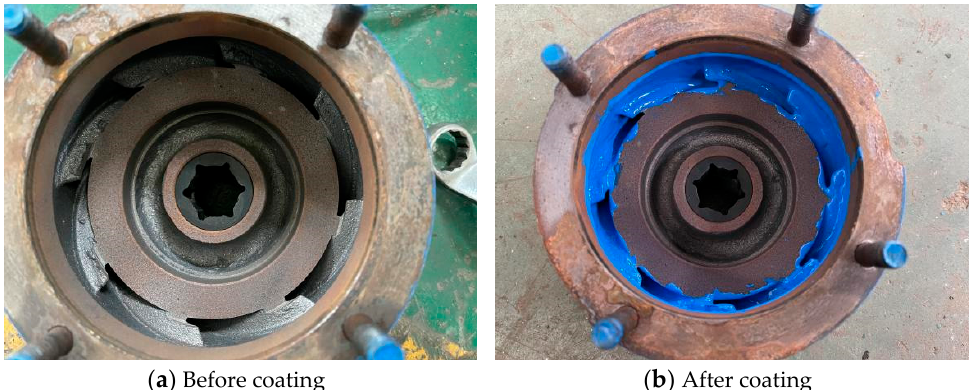
Figure 24. Test pump.